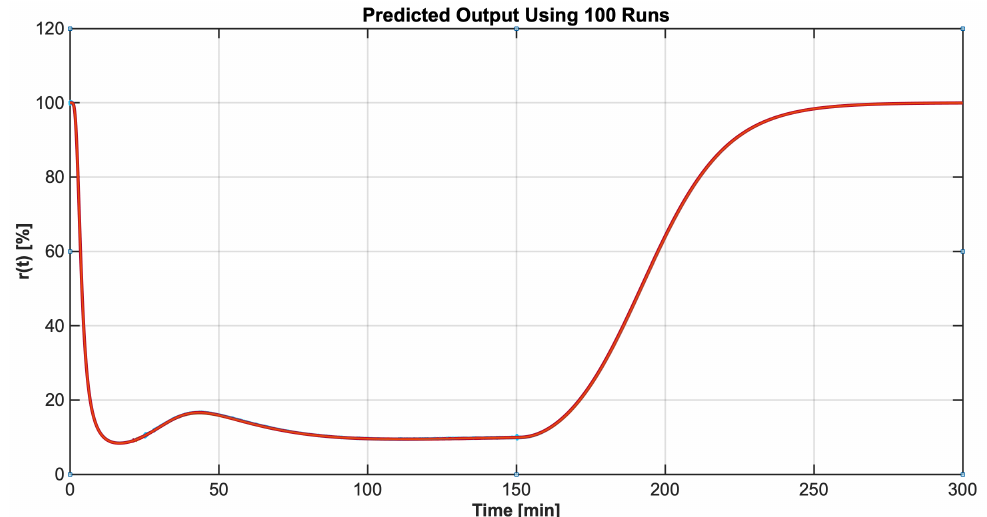
Figure 6. The predicted ouptut in 100 Monte Carlo runs using the proposed PSO-based Wiener Box-Jenkins identification